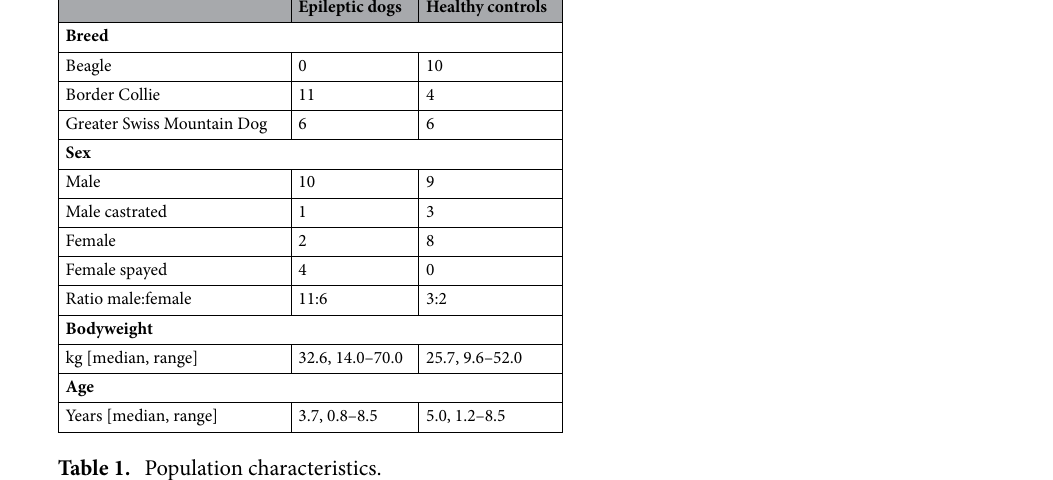
Table 1. Population